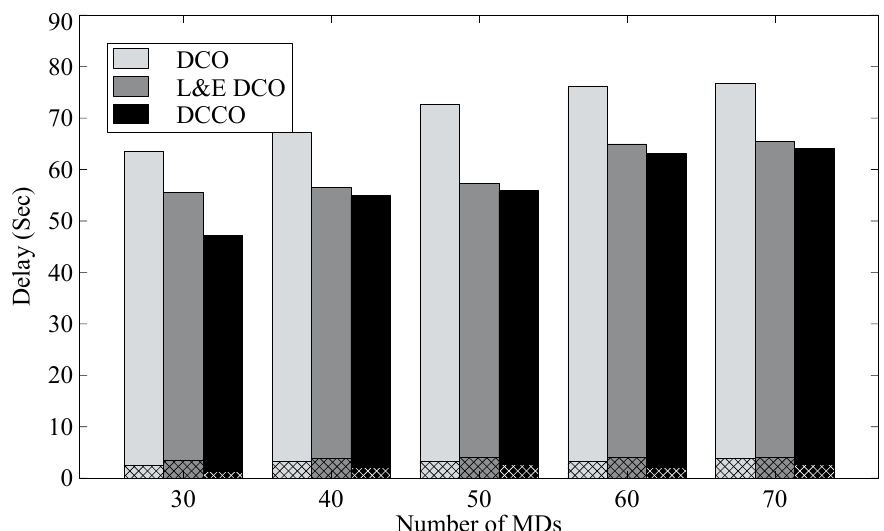
Figure 7. The average delay with different algorithms.